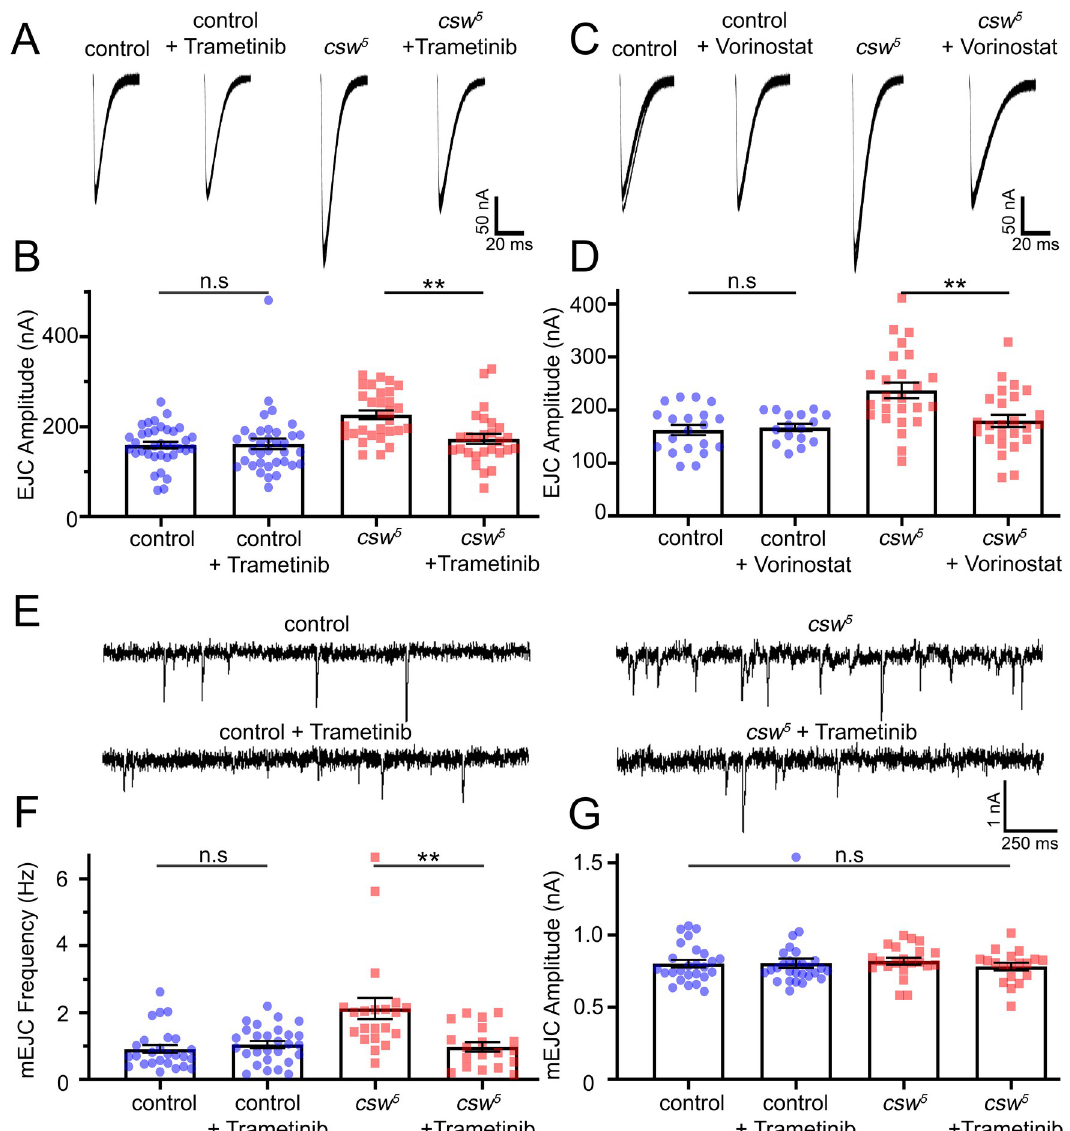
Fig 5. Reducing pERK signaling restores synaptic function in csw nulls. TEVC recordings with and without two pERK inhibiting drugs (Trametinib and Vorinostat) comparing the genetic background control ( w 1118 ) and csw null mutant ( csw 5 ). ( A) Representative EJC traces showing 10 superimposed responses (1.0 mM Ca +2 ) comparing the control (left) and csw 5 null mutant (right), with and without Trametinib. ( B) Quantification of mean EJC amplitudes for all 4 conditions using Kruskal–Wallis followed by Dunn’s multiple comparisons. ( C) Representative EJC traces comparing the control (left) and csw 5 null mutant (right), with and without Vorinostat. ( D) Quantification of EJC amplitudes for all 4 conditions using one-way ANOVA followed by Tukey’s multiple comparisons. ( E) Representative mEJC traces (1.0 mM Ca 2+ ) in the w 1118 control (left) and csw 5 null mutant (right), with and without Trametinib. ( F) Quantification of mEJC frequency in all 4 conditions using a Kruskal–Wallis followed by Dunn’s multiple comparisons. ( G) Quantification of mEJC amplitudes using a Kruskal–Wallis. Scatter plots show all the data points and the mean ± SEM. N = number of NMJs. Significance: p > 0.05 (not significant, n.s.) and p < 0.001 ( �� ). The data underlying this figure can be found in S1 Data. EJC, excitatory junction current; mEJC, miniature EJC; NMJ, neuromuscular junction; pERK, phosphorylated ERK; TEVC, two-electrode voltage-clamp. target) as the internal positive control [17]. Immunoprecipitated mRNAs were reverse tran- scribed and tested with specific primers on 2% agarose gels. We next used western blots from larval ventral nerve cord (VNC)/brain lysates to test neuronal Csw protein levels with a